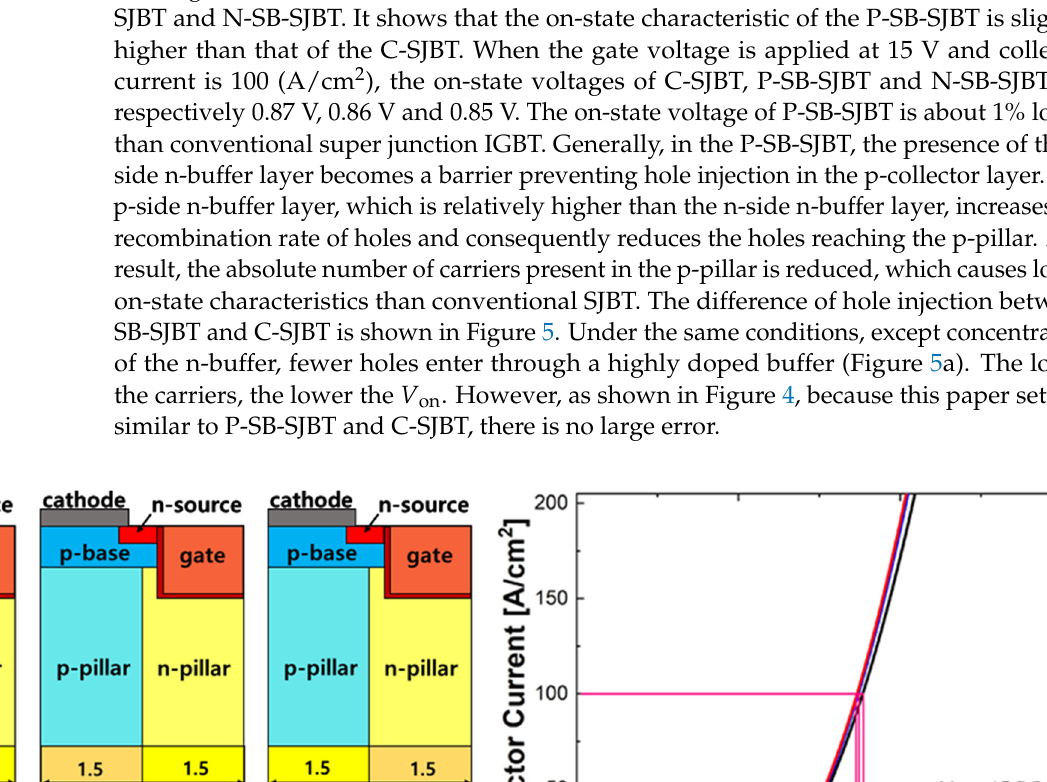
Figure 5. ( a ) Hole density of P-SB-SJBT, and ( b ) C-SJBT. Buffer concentration of ( a ) consist of 3 × 10 (cid:2869)(cid:2875) cm − 3 and 3 × 10 (cid:2869)(cid:2874) cm − 3 , and concentration of ( b ) consist of only 3 × 10 (cid:2869)(cid:2874) cm − 3 . 3.4. Breakdown Characteristics Figure 6a,b shows the breakdown voltage characteristics and electric field distribu- tion in the p-pillar. From Figure 6a, we can see that the breakdown voltage of P-SB-SJBT is 632.7 V, which decreased by 0.51% compared to C-SJBT of 635.9 V. It also increased by 0.72% compared to N-SB-SJBT of 627.5 V. The difference between the breakdown voltage of the two devices appears as a change in the slope of the electric field distribution due to the difference in doping concentration of the p-side n-buffer layer. Since the width of the structure is 3.0 µm, the electric field distribution was measured according to y (=length) at the p-pillar near x (=width) of 0.75 µm which is half of the p-pillar. The result is shown